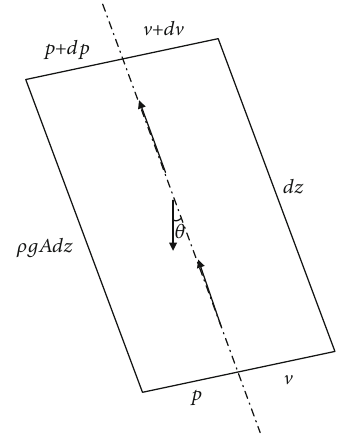
Figure 1: Column coordinate